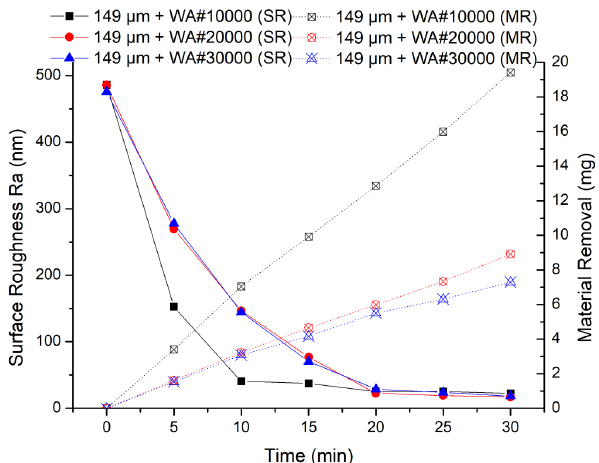
Figure 8. MAF process experimental results (149 μm electrolytic iron powder).